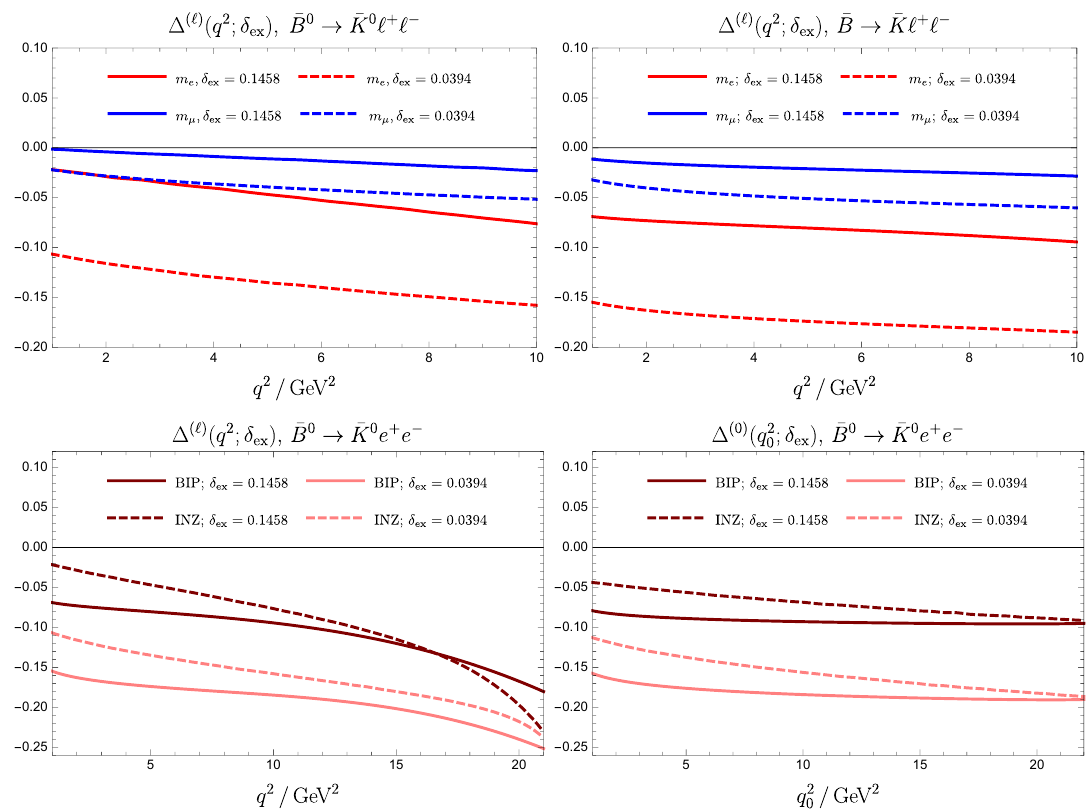
Figure 9 . Relative effects of relative corrections as a function of q 2 , in the neutral case, with the cuts on m rec used in [6] computed in this work (top left) vs. those presented in [6] (top right). The B bottom left and bottom right plots compare our results with those in [6] for the q 2 and q 2 respectively. The translation between the notation of this reference and ours is δ ex = 1 − ( m rec with ( ¯ p B = m rec ) and { 0 . 1458 , 0 . 1 , 0 . 0394 } ↔ m rec = { 4 . 88 , 5 . 009 , 5 . 175 } B B